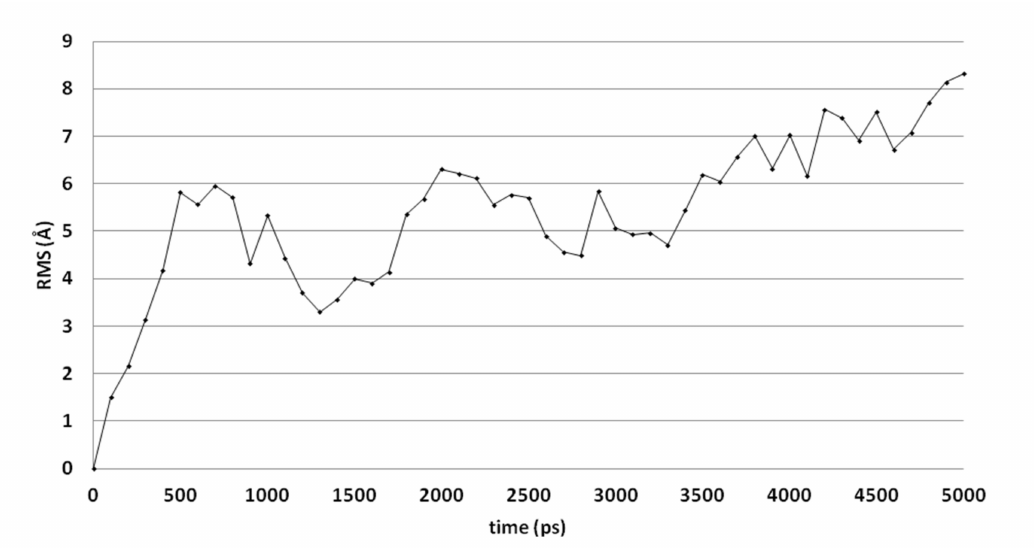
Figure 3. The RMSD of the ligand heavy atoms during the 5-ns molecular dynamics simulation of compound 4o in the active site of